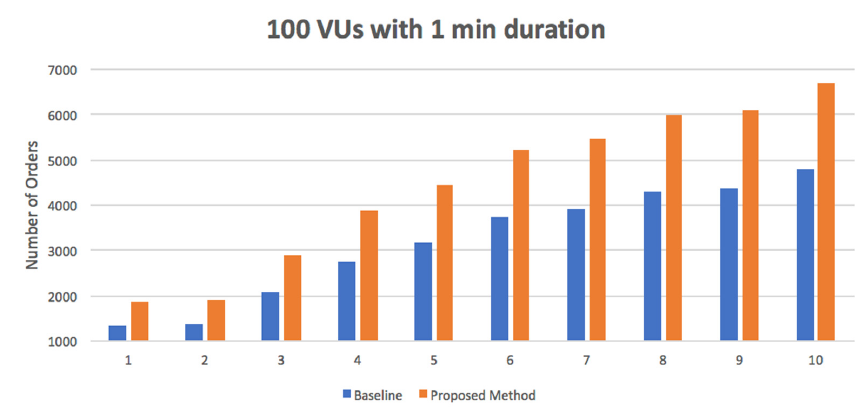
Figure 17. Load Testing—100 virtual users with 1 min duration. Appl. Sci. 2022 , 12 , x FOR PEER REVIEW